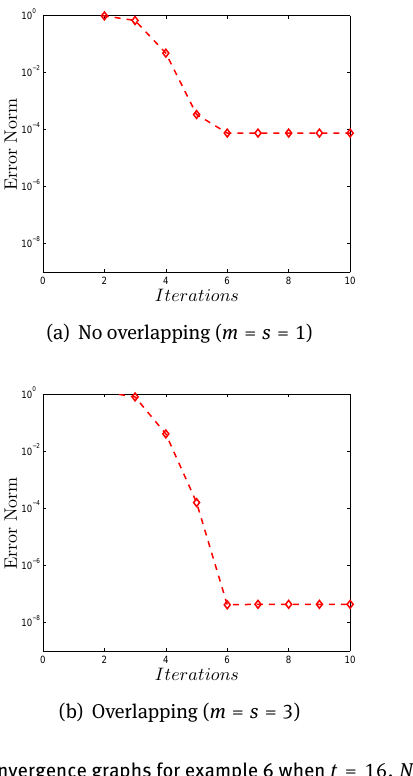
Figure 16: Convergence graphs for example 6 when t = 16, N t = 5 and N x =